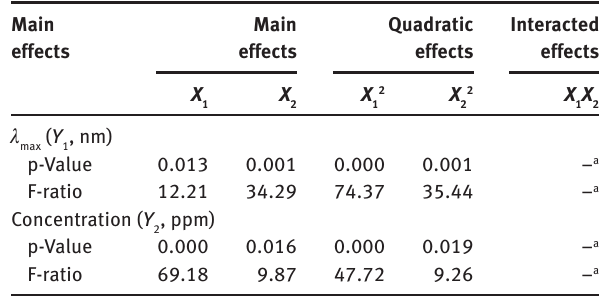
Table 3: The significance probability (p-value and F-ratio) of regres- sion coefficients for the final reduced models suggested for AuNPs